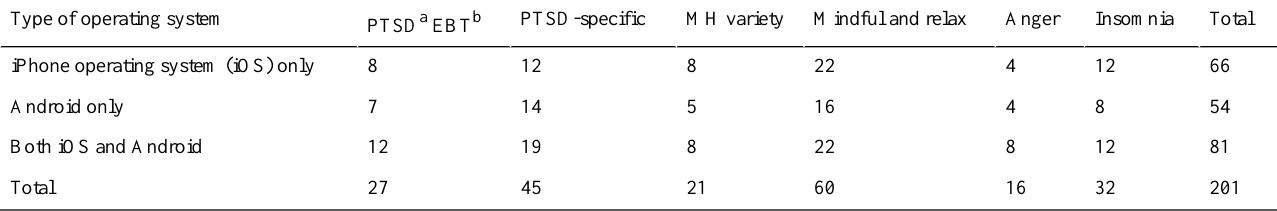
Table 1. The app categories grouped by the type of operating system.